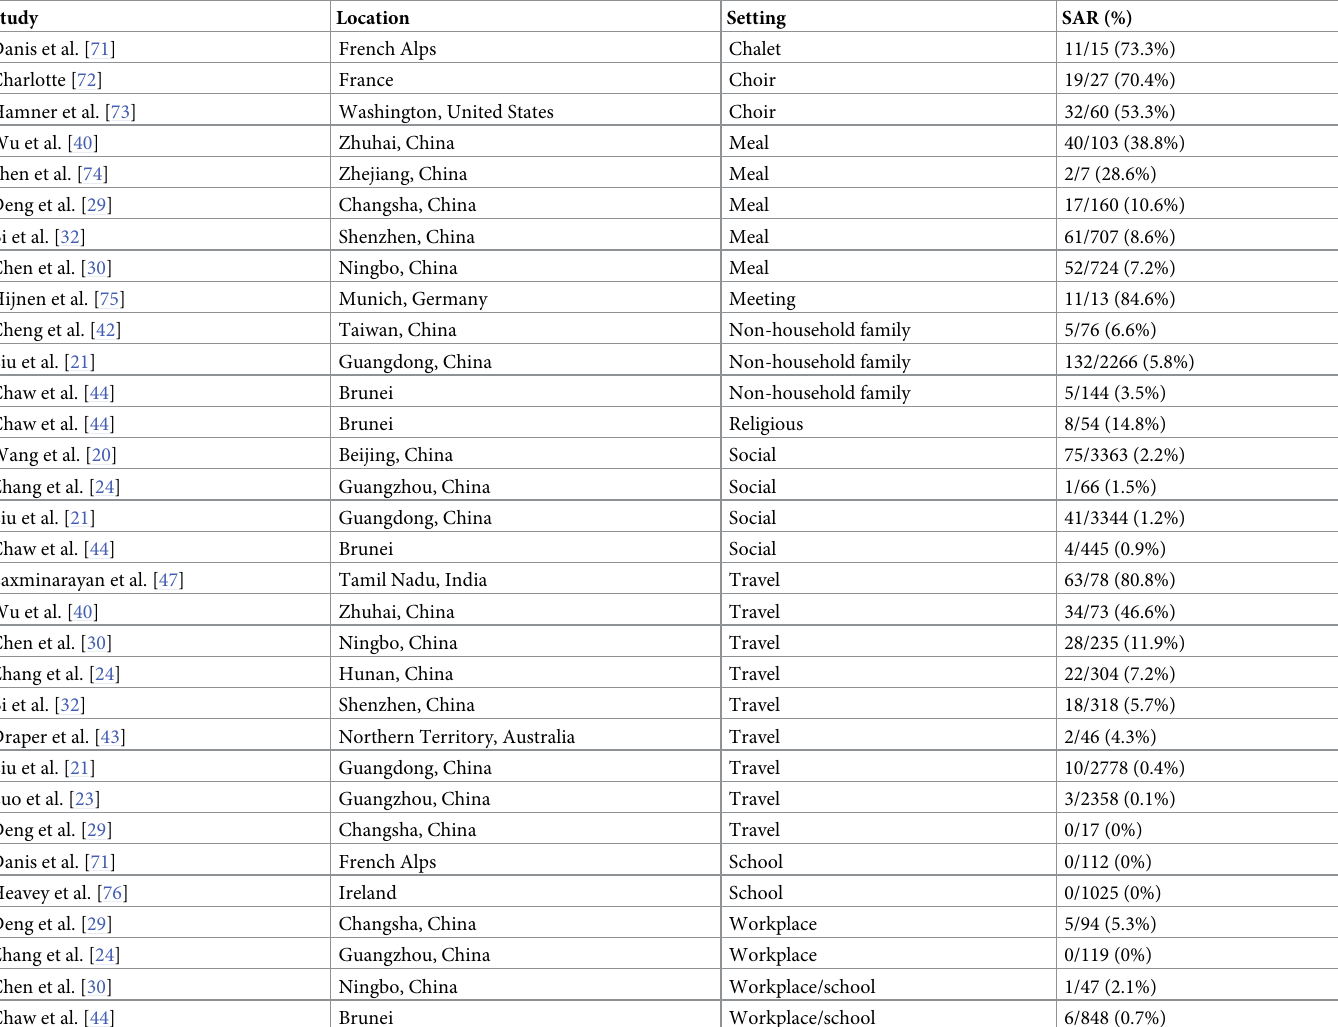
Table 3. Studies of secondary attack rate (SAR) in settings outside household and